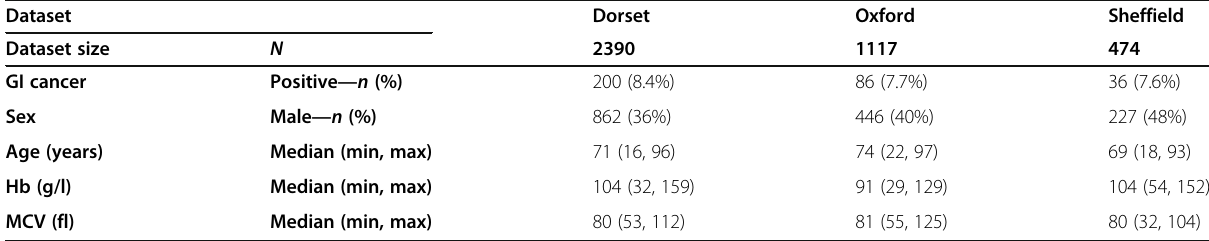
Table 2 Descriptive statistics for the three datasets